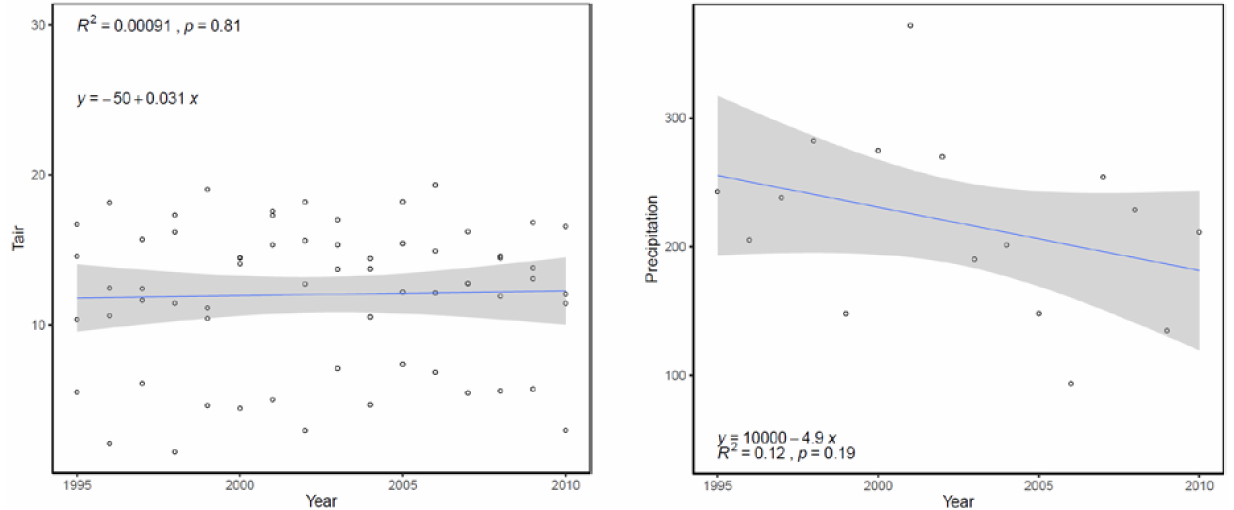
Figure A3. Monthly air temperature (Tair, ◦ C) and precipitation (mm) over the growing season (June–September) at wildfire-affected sites of different ages in the 1995–2010 study period according to Tura Weather Station (www.meteo.ru). Grey areas represent standard errors. Blue line represents linear